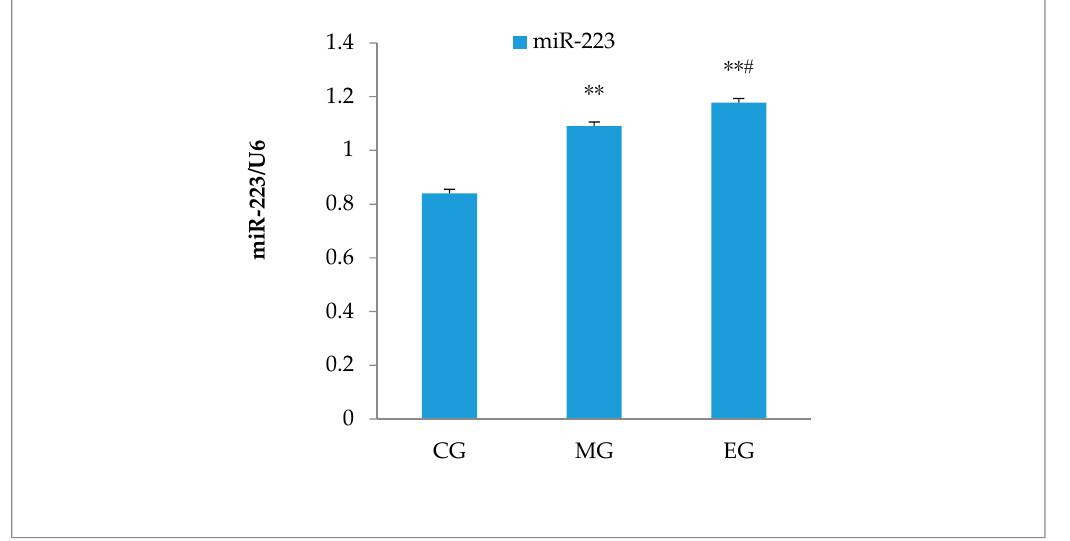
Figure 6. The miR-223 expression in the hippocampus of CUMS mice after 8 weeks of exercise by the RT–PCR assay. The data were presented as means ± SD; there were six mice in each group. U6 was set as the reference gene. ** p < 0.01, versus control group, # p < 0.05, versus model group.